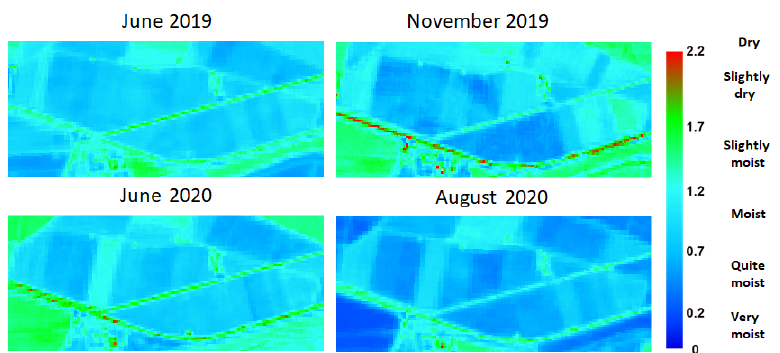
Figure 13. MSI index evolution in stone fruit tree